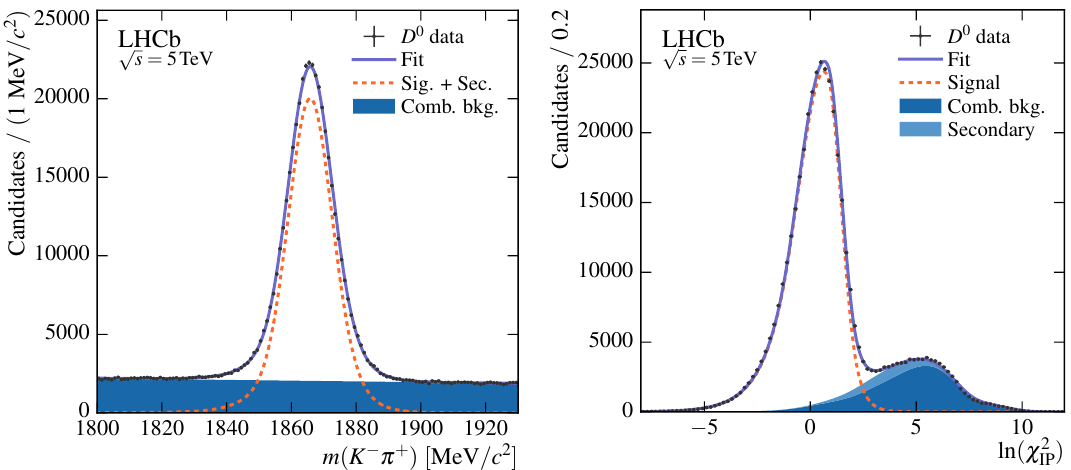
Figure 1. Distributions for selected D 0 (cid:0) (cid:1) (right) ln (cid:31) 2 for a mass window of IP